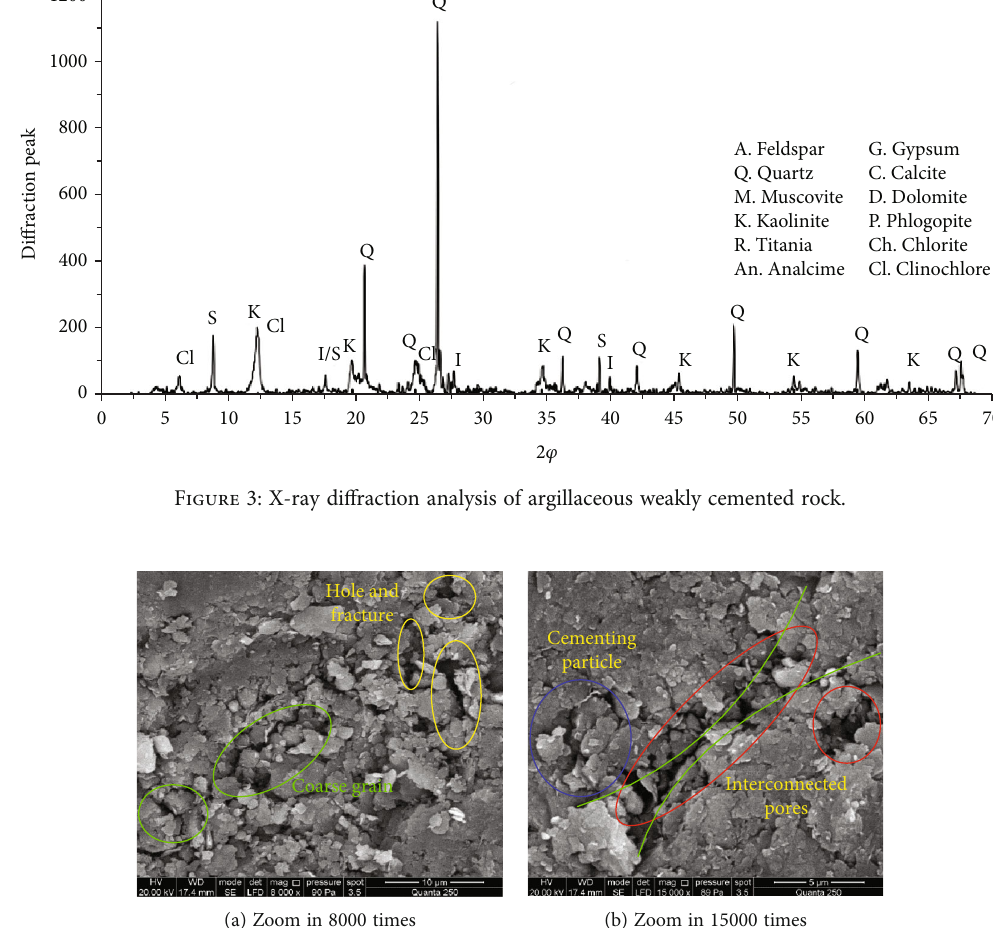
Figure 4: Scanning electron microscope results of